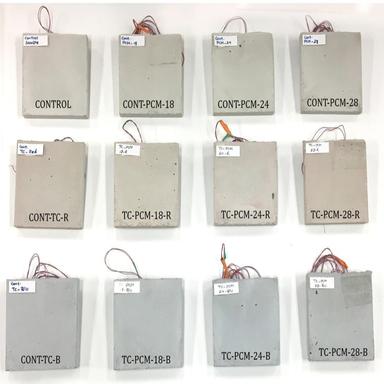
Developed Type 1 cement plaster samples.